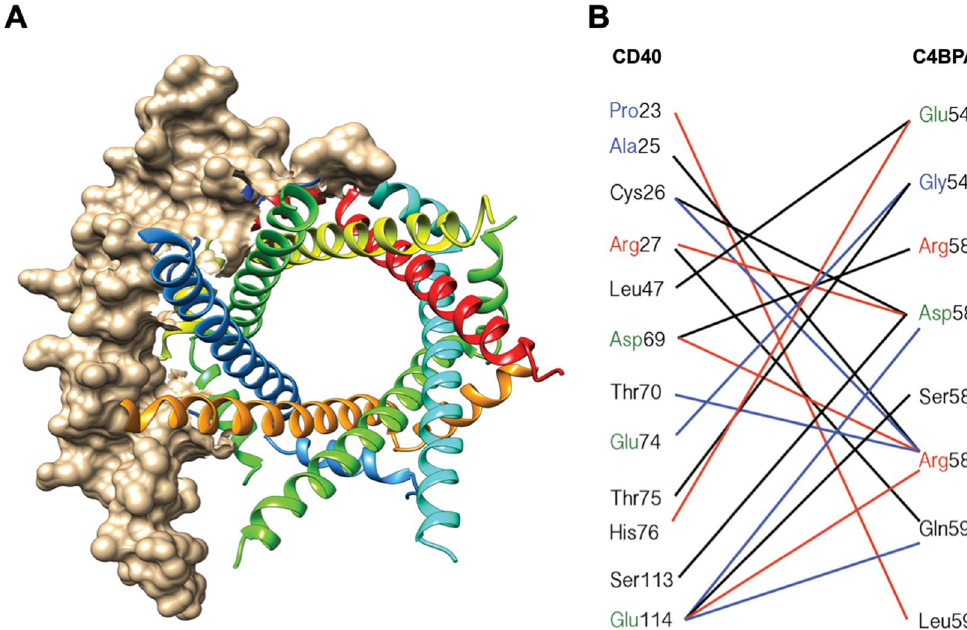
Figure 3. Structure of CD40 (PDB code, 3QD6) - heptameric C4BPA (PDB code, 4B0F) interaction interface. ( A ) Protein-protein docking was conducted through FireDock Server, followed by analysis with use of the Chimera program (UCSF). ( B ) Residues making direct contacts are linked by lines, which are alternatively color-coded simply for a convenient visualization. Positive residues, red; negative, green; hydrophobic, blue; hydrophilic,